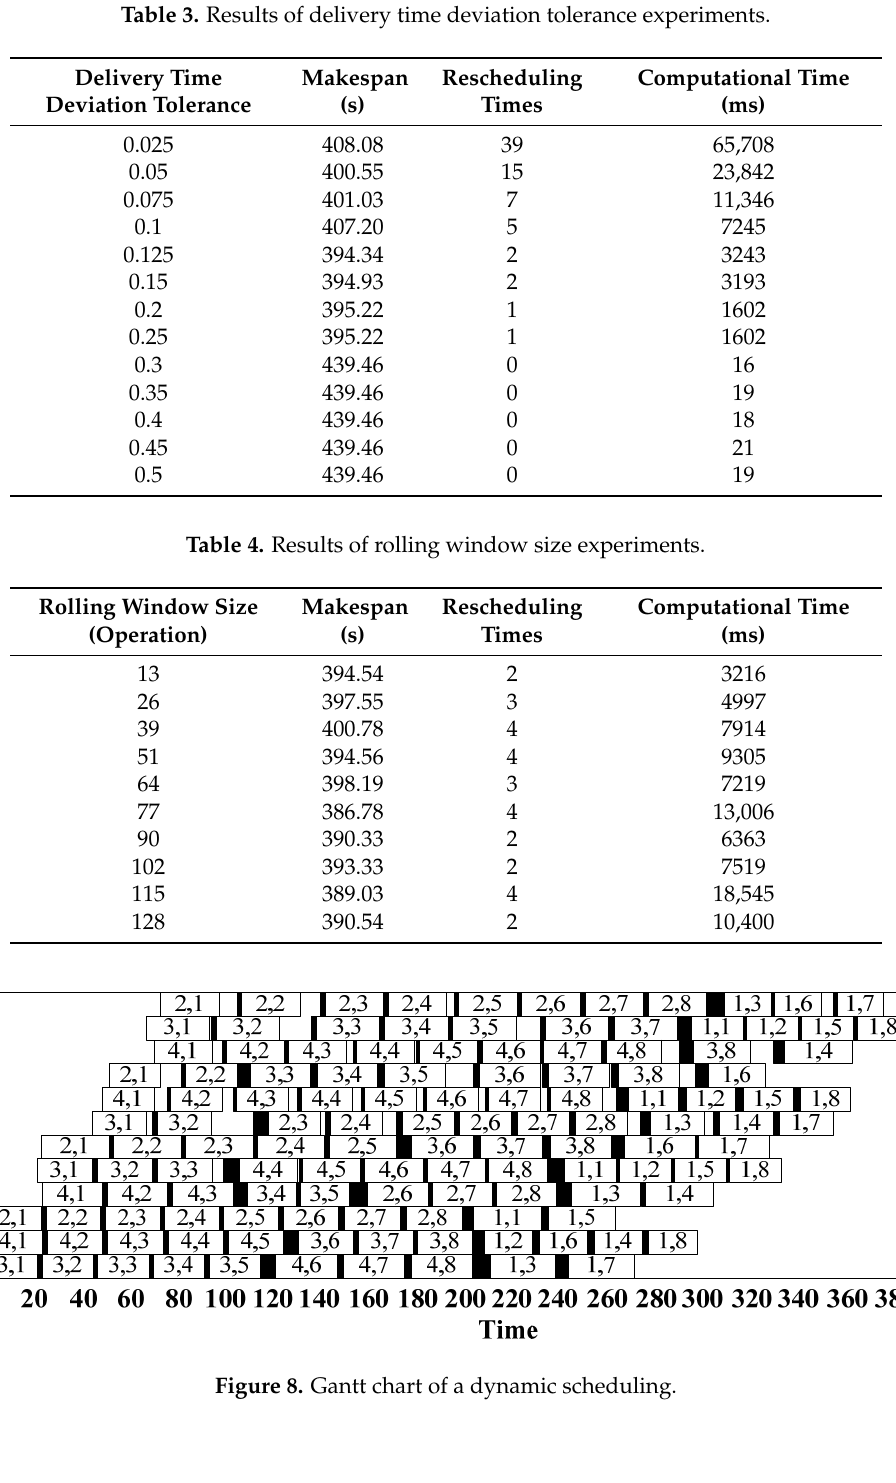
Table 5. Nine benchmarks for dynamic HFS (Hybrid Flow Shop) scheduling. Benchmark